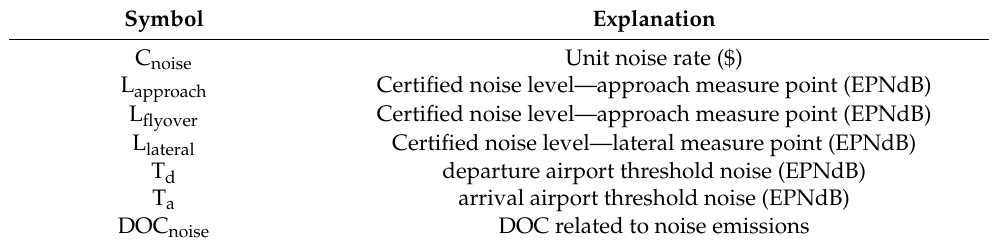
Table 8. Noise cost symbols explanation.